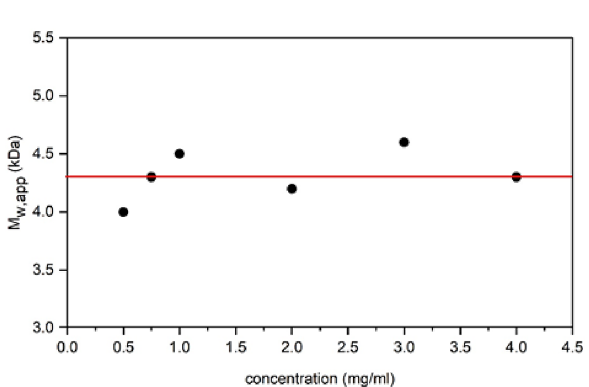
Table 1. The M w,app and Đ values obtained from the sedimentation equilibrium experiment for all concentrations. The M w,app values obtained by the hinge point analysis were all slightly lower than the M w,app ( M *) values.